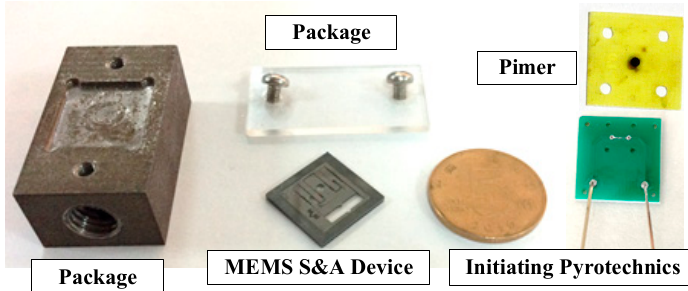
Figure 12. Integrated MEMS S&A device.